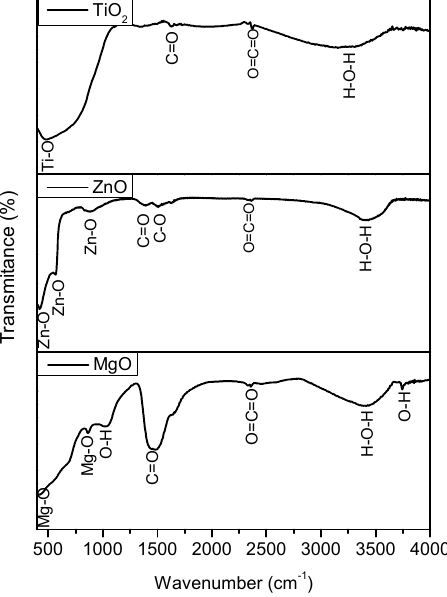
oxide samples (Figure 3b) in this paper are as follows: TiO 2 - E g = 3.57 eV, ZnO- E g = 3.51 eV and MgO- E g = 3.91 eV.